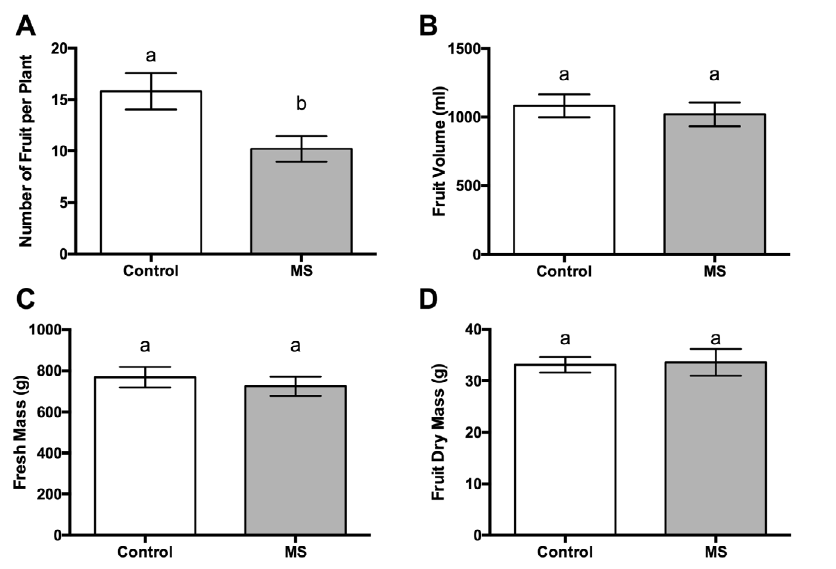
Figure 5: Fruit production metrics for control and mechanically stimulated pepper plants: (A) Average number of mature fruit per plant; (B) Mean total fruit volume per plant; (C) Mean total fruit mass per plant; (D) Mean total fruit dry mass per plant. Columns with the same letter appearing above do not differ at p≤0.05. Error bars are